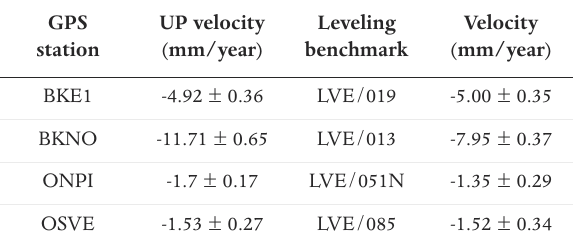
Table 4. GPS velocities and average velocity of the leveling bench- marks closest to GPS